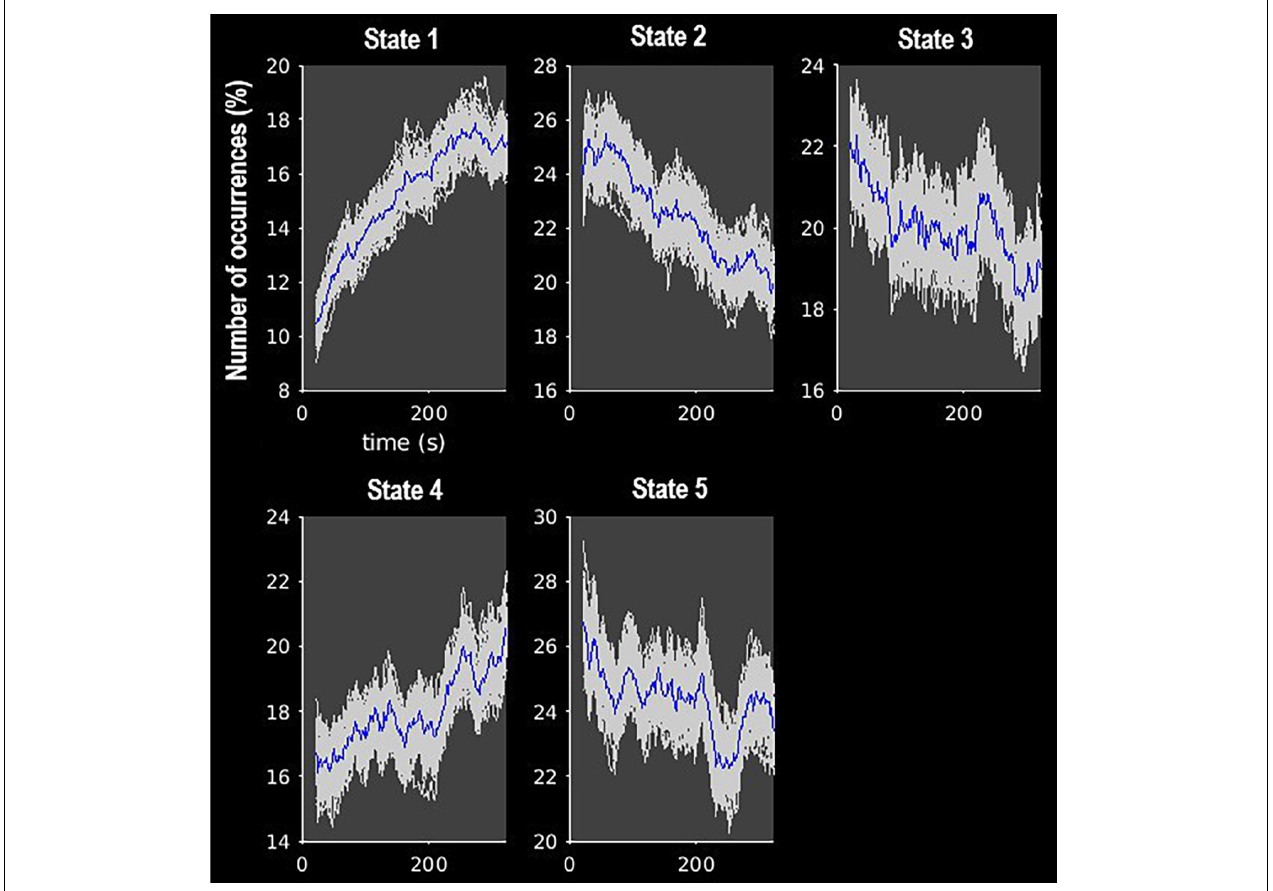
FIGURE 4 | Frequency of occurrence of each state over the course of the MRI scan. Gray lines indicate the estimated occurrence profiles of each state for 100 bootstrap resamples with